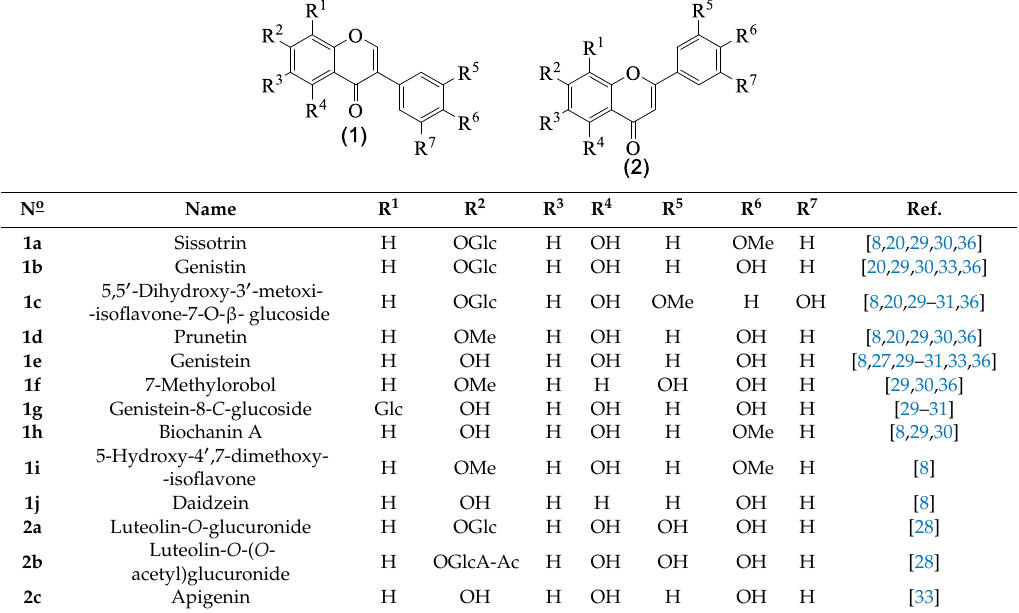
Figure 1. Structure of the classes of flavonoid derivatives found in G. tridentata . Table 2. Isoflavones and flavones produced by G. tridentata .